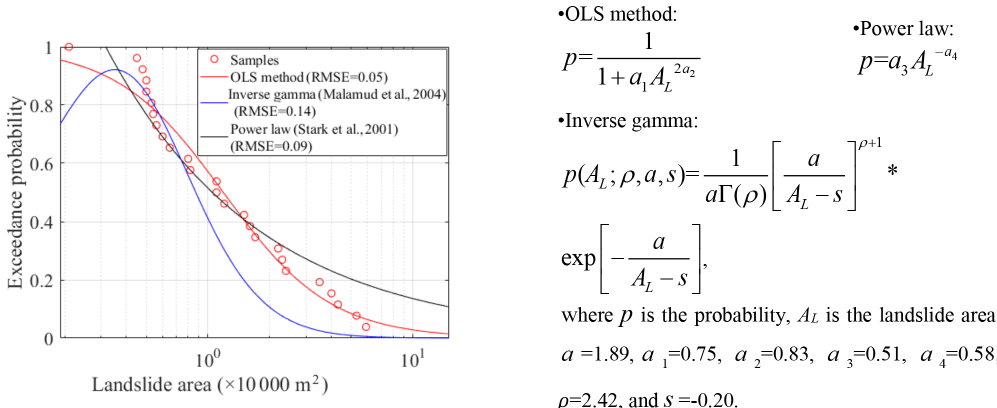
Figure 10. Magnitude–frequency relationships simulated by the ordinary least squares (OLS) method, inverse gamma, and power law for landslide in western Hubei. The samples are presented in Table 2 and involve the Chengguan database except for the study area.